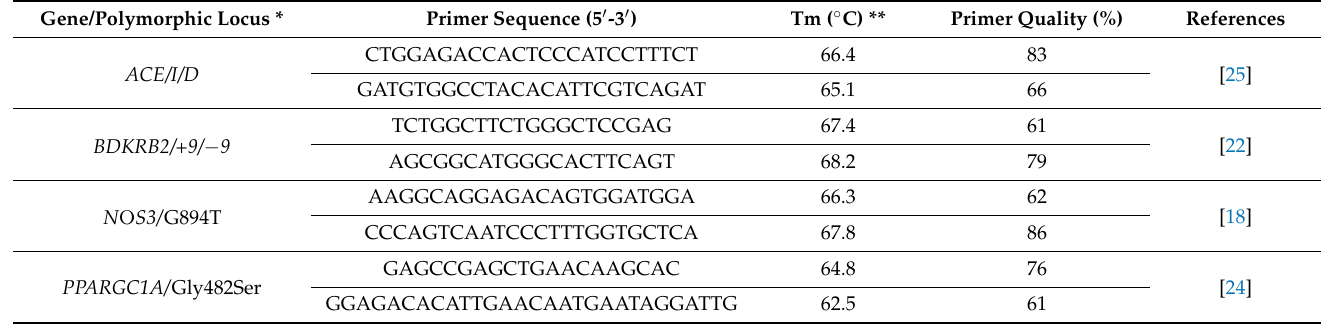
Table 1. Primers for amplification of polymorphic loci of four genes in martial arts practitioners. Gene/Polymorphic Locus * Primer Sequence (5 (cid:48) -3 (cid:48)